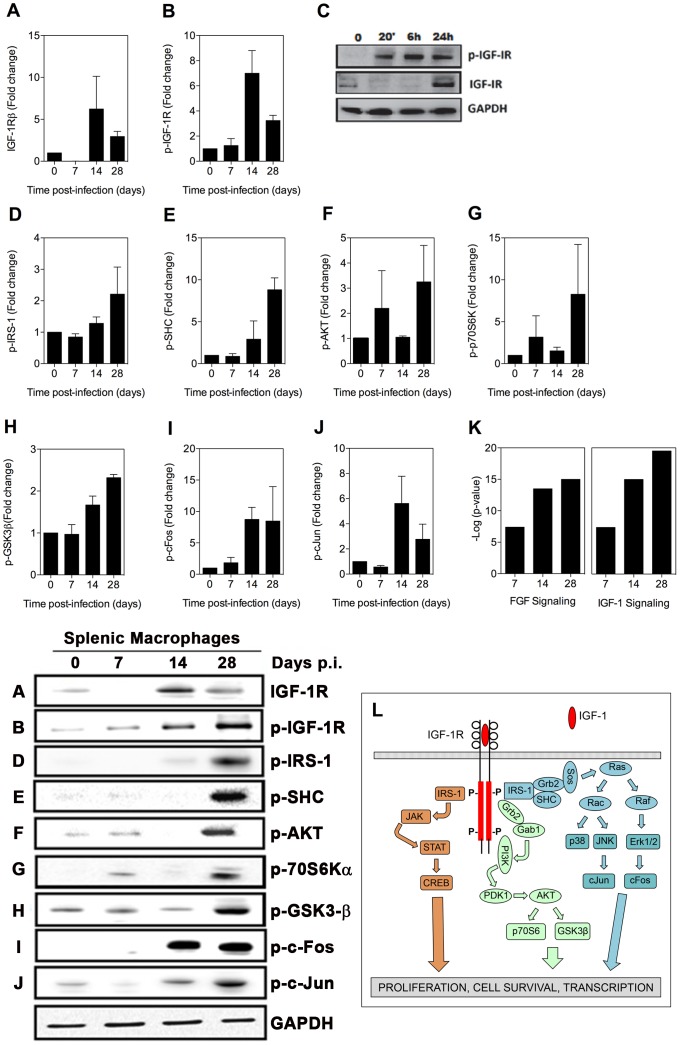
Activation of signaling proteins in the IGF-1R canonical pathway in splenic macrophages from hamsters with VL.(A–B, D–J) Immunoblot analysis of expression of proteins in the IGF-1R canonical signaling pathway in splenic macrophages was performed as described in Fig. 2. C) Detection of phospho-IGFR by immunoblot in BMDMs uninfected (Un) or infected in vitro with L. donovani for 20 min to 24 hrs. Shown is an immunoblot from a single experiment. K) Network analysis showing the activation of the FGF and IGF-1 canonical signaling pathways generated by comparing the fold change of 32 signaling proteins in splenic macrophages from uninfected and infected (7, 14, and 28 days) hamsters using Ingenuity Pathway Analysis software (Ingenuity Systems). The –log of the p value (vertical axis) represents the probability that the association of the data set in that pathway is due to chance. L) Simplified schematic of the canonical IGF-1 signaling pathway for reference.